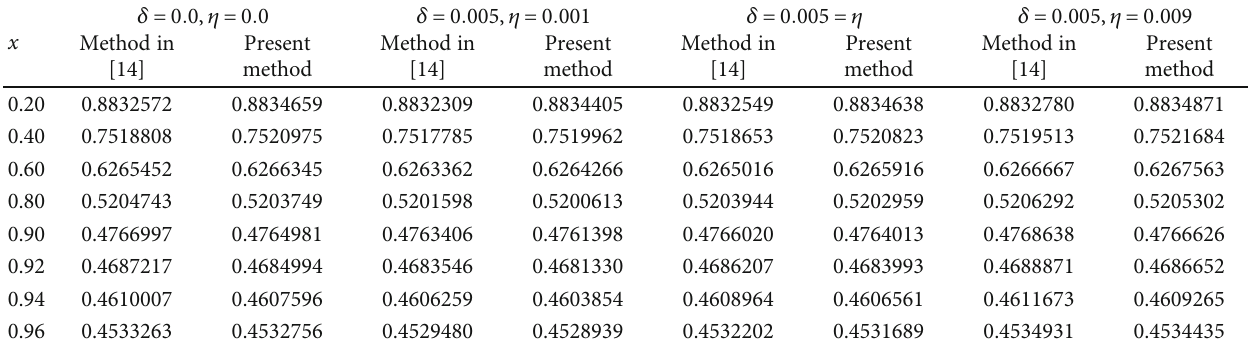
Table 5: Numerical results of Example 7 for ε = 0 : 01, N = 100 .